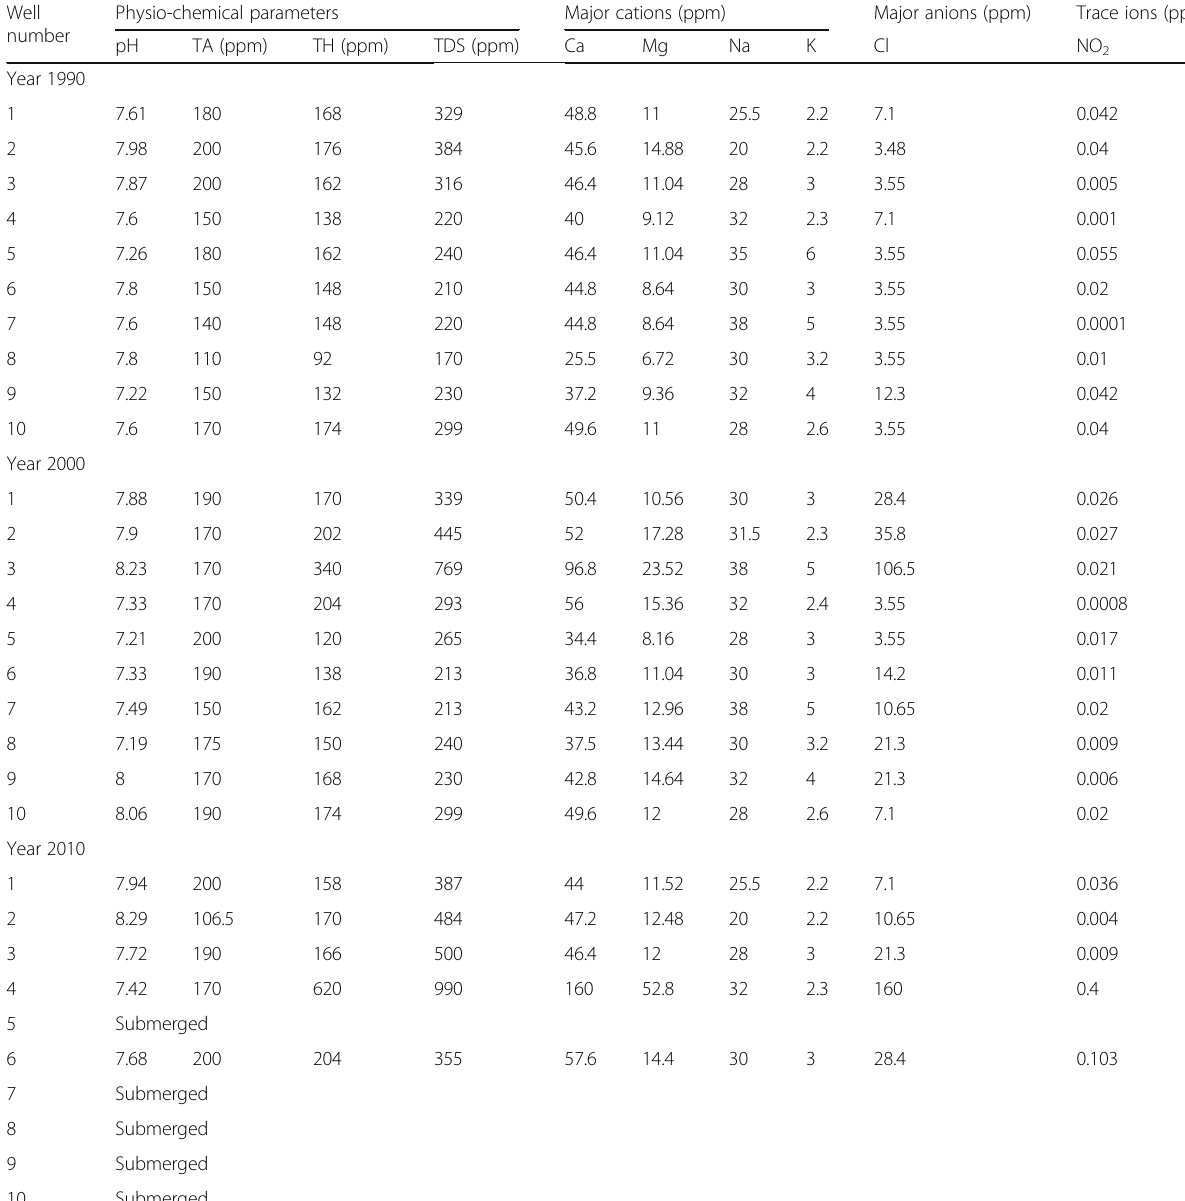
Table 1 Results of the physical and chemical analysis of some groundwater samples Well Physio-chemical number